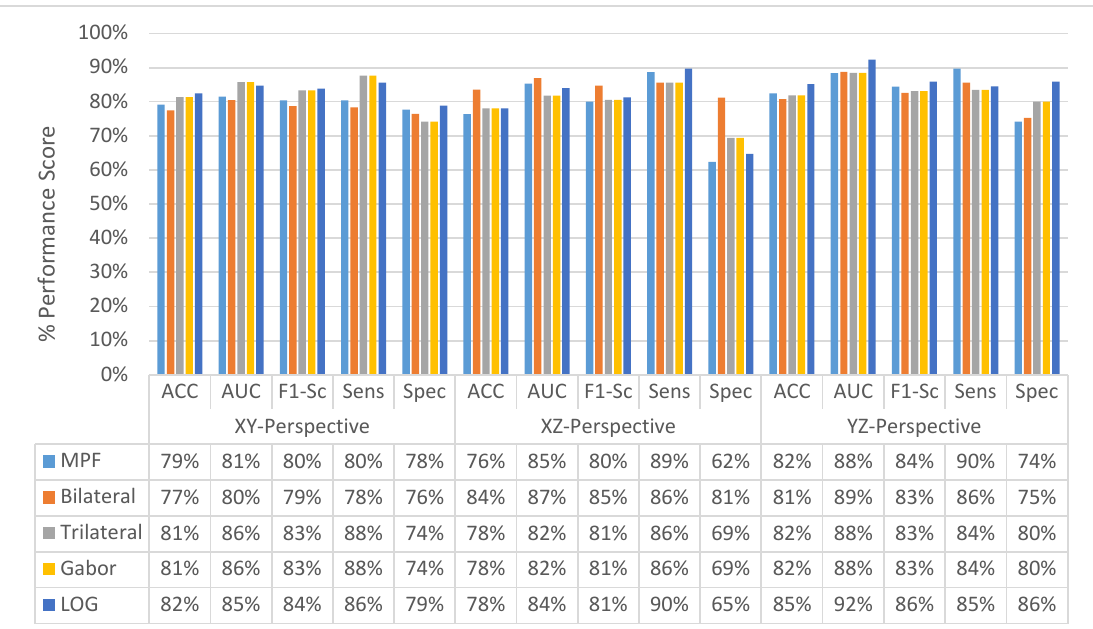
Figure 36. Change in perspective-level classification performances for each SFMPF model for each perspective.